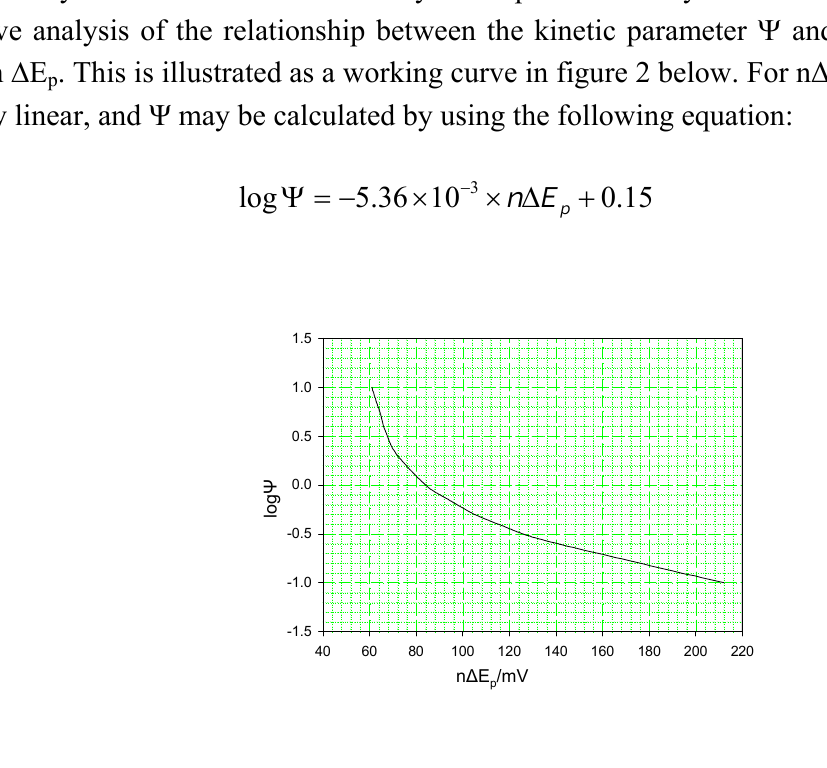
Figure 2. The variation of the kinetic parameter Ψ with voltammetric peak separation